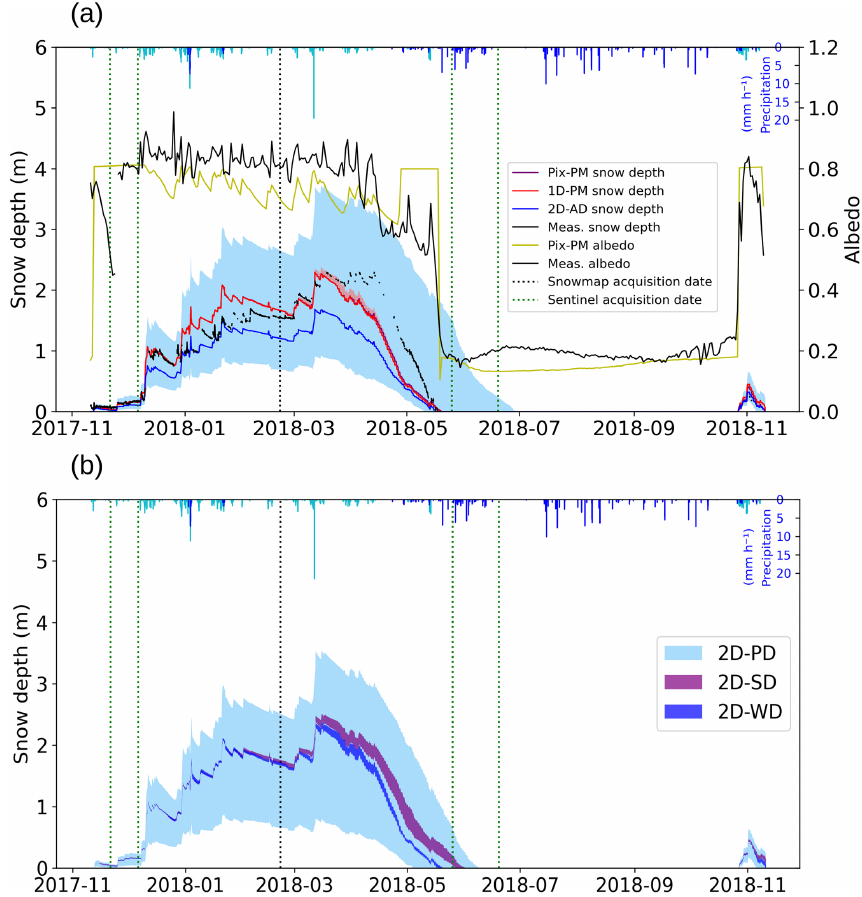
Figure 9. (a) Snow depths (left axis) for different simulations compared with observations (black line). Colored lines show the average depths over the catchment, and shading shows the spatial variability. Right axis: observed (black line) and 1D-PM-simulated (yellow line) albedo. Averaged precipitation (rain in blue and snow in cyan) is plotted at the top of the graph. Panel (b) shows the same as (a) but for the only precipitation (2D-PD), only shortwave radiation (2D-SD), and only wind speed (2D-WD) distributed runs. Table 4. Statistical metrics for observed and simulated parameters in different simulations (MBE: mean bias error, RMSE: root mean square error). Evapotranspiration and albedo statistics are calculated over a wind direction mask in the catchment.